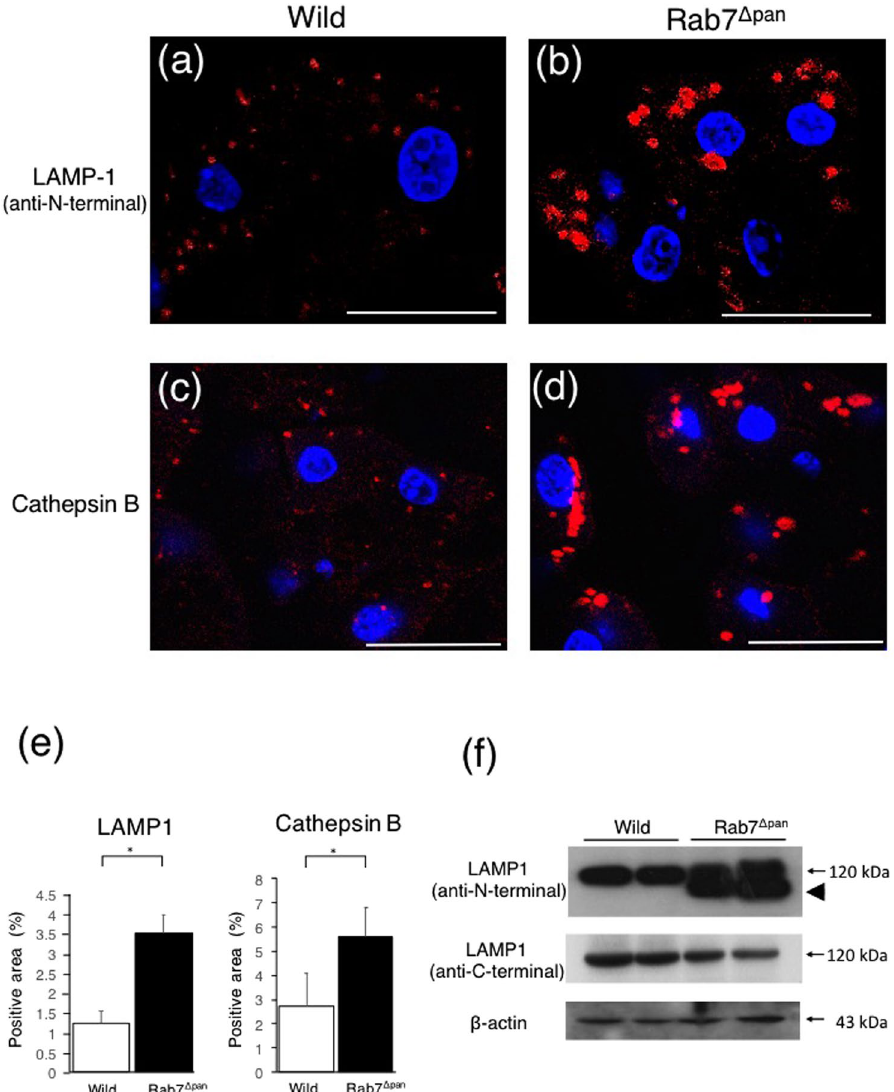
Figure 6. Alteration of the size of lysosomes and the expression of LAMP-1 in in Rab7 Δ pan pancreatic acinar cells. ( a–d ) Immunofluorescence images of wild ( a , c ) and Rab7 Δ pan ( b , d ) pancreases stained with anti- LAMP1( a , b ) or anti-cathepsin B ( c , d ) antibodies (red). DAPI was used for nuclear staining (blue). Bars: 20 µ m. ( e ) Quantification of the positive signals in immunofluorescence images of LAMP-1 (left panel) and cathepsin B (right panel). * P < 0.05. ( f ) WB of LAMP-1 using total pancreas homogenate of wild and Rab7 Δ pan mice. An antibody against LAMP-1 N-terminal (top panel) and an antibody against LAMP-1 C-terminal (middle panel) were utilized. Anti-LAMP-1 N-terminal antibody revealed the shifting of intense bands to a lower position (top panel, arrow head) than that of full-length LAMP-1 (120 kDa) in Rab7 Δ pan pancreas. In contrast, anti-LAMP-1 C-terminal antibody revealed bands at 120 kDa only in both wild and Rab7 Δ pan pancreas (middle panel). β -actin was used as an internal loading control (bottom